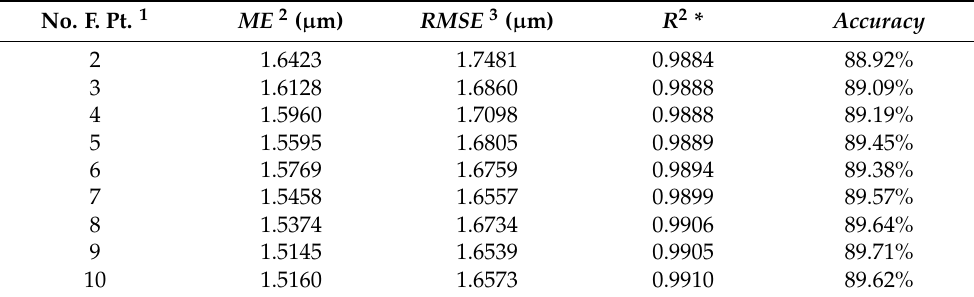
Table 3. The influence of the number of the feature temperature points on the external validation result of the thermal error model trained through GPR under variable speed conditions.